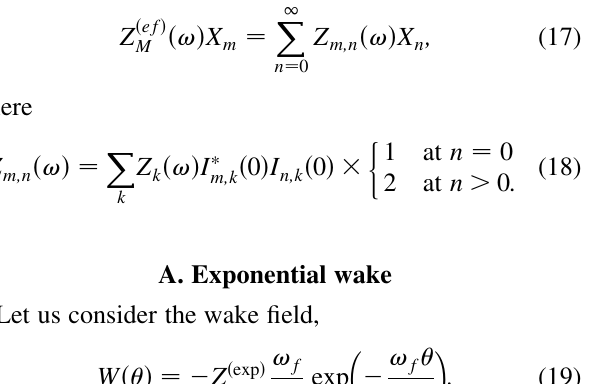
FIG. 1. Real part of exponential wake effective impedance. Circles—numerical solutions at !=! solid line—analytical solution